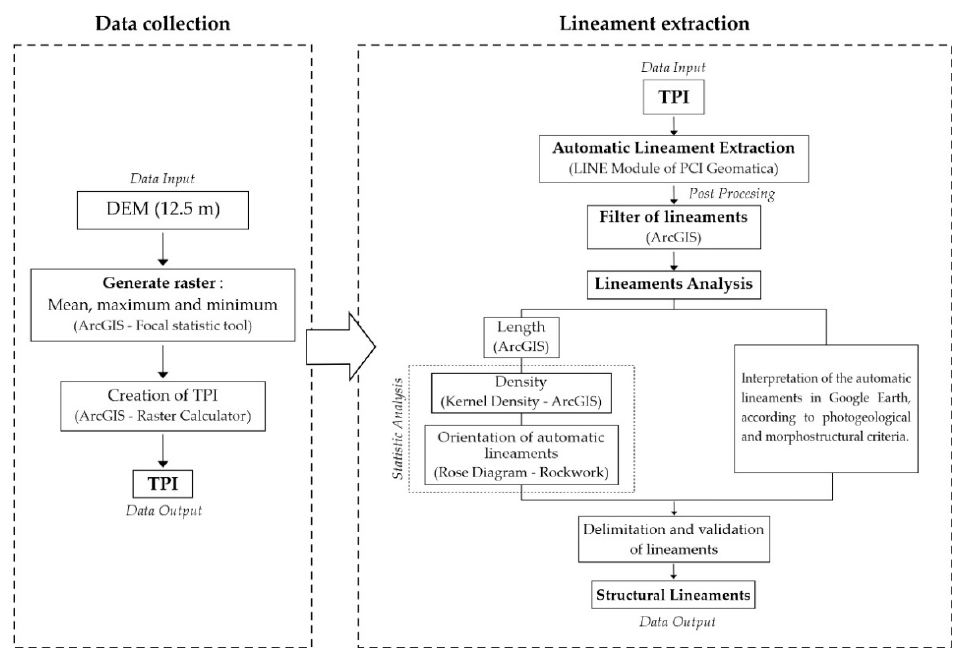
Figure 5 . Methodology employed in this